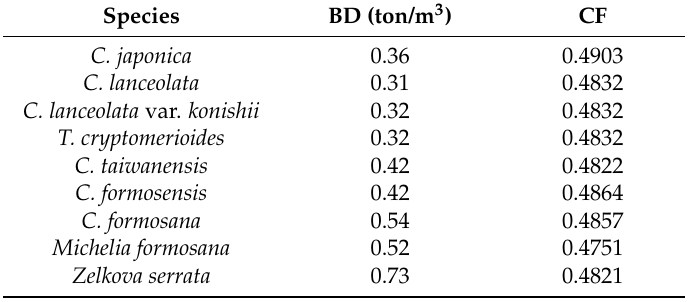
Table 3. Basic wood density (BD) and carbon fraction (CF) values of species common for thinning operations. Species BD (ton/m 3 )